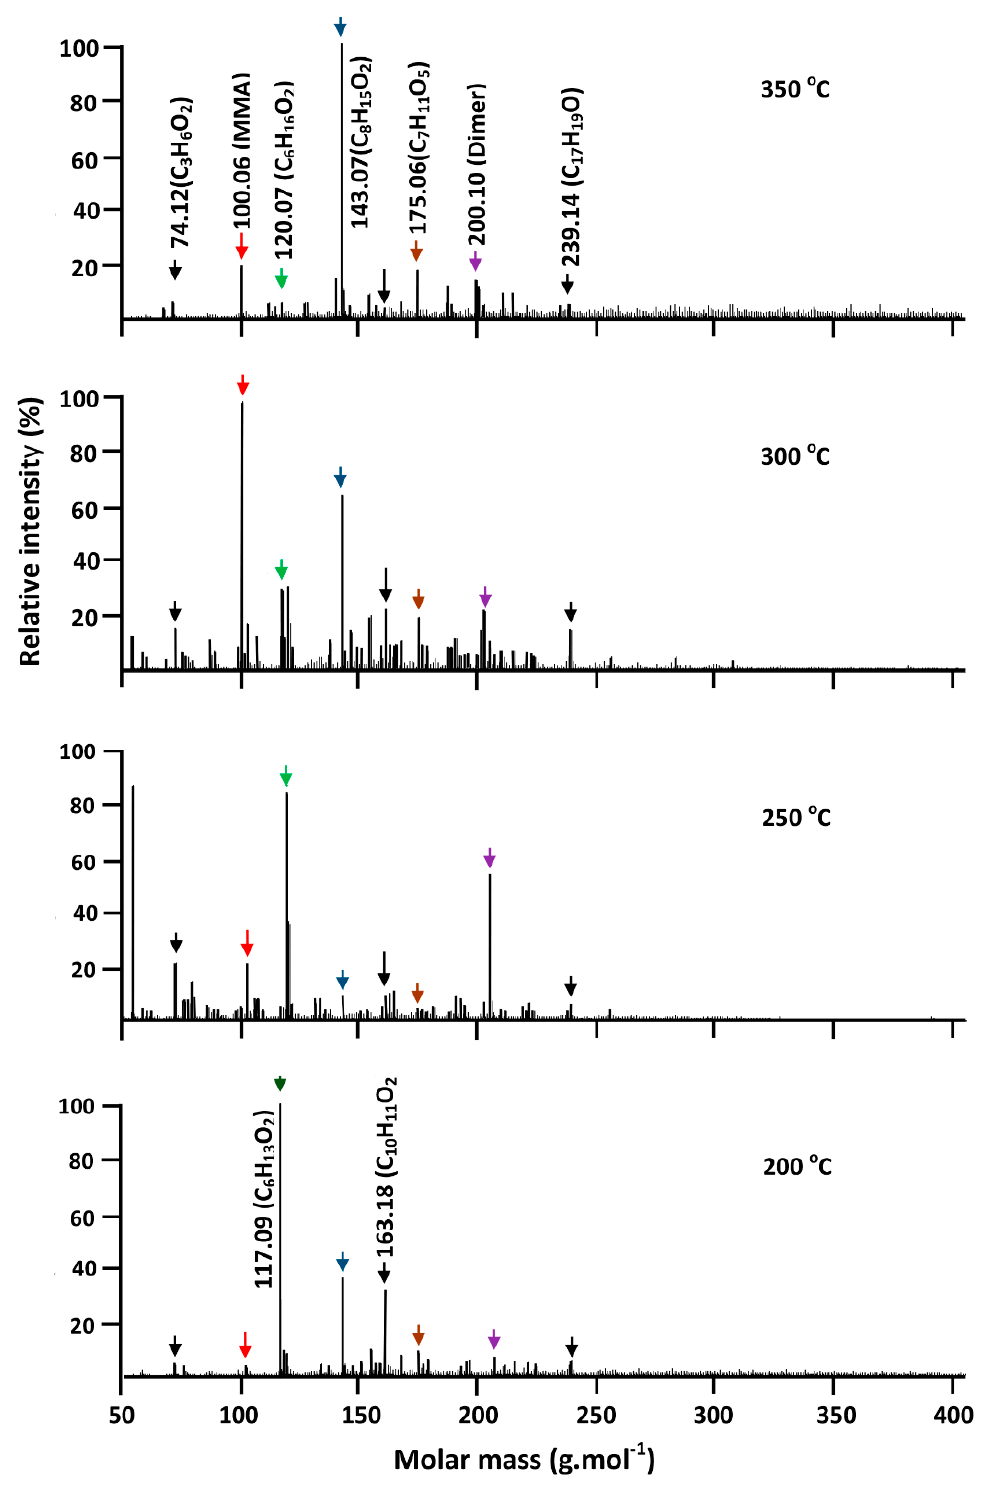
Figure 18. Thermograms of isothermal decomposition of PMMA indicating intensity of absorption signal attributed to resulting products vs. molecular weight.